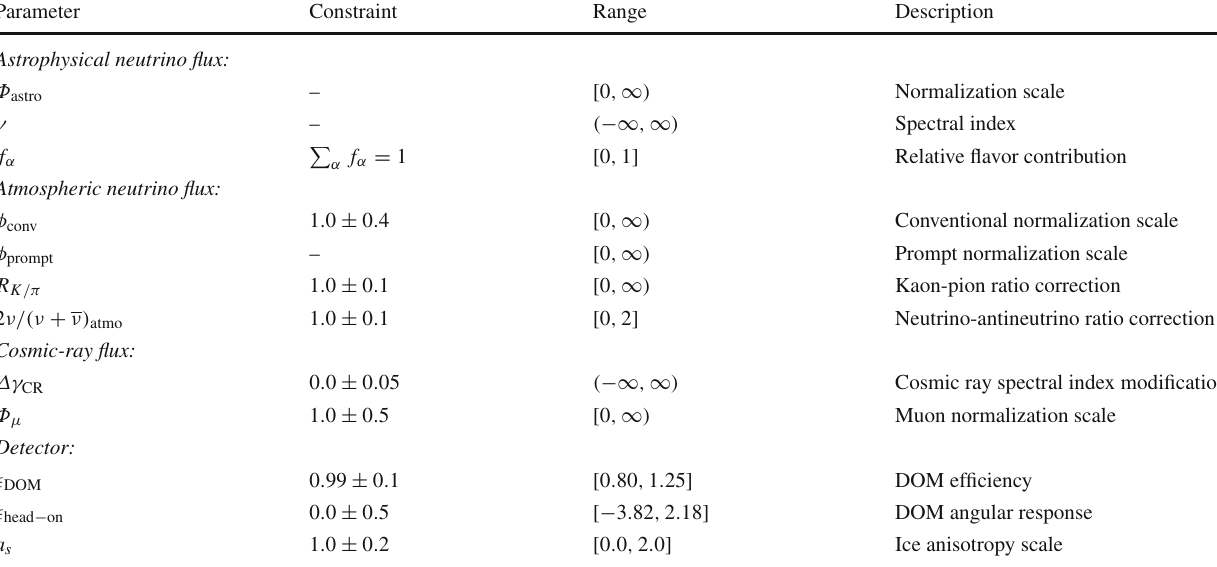
straints, while constraint-free parameters are denoted with “-”. Bounds are given for all parameters. Note that the f α parameters are unique to the analysis presented